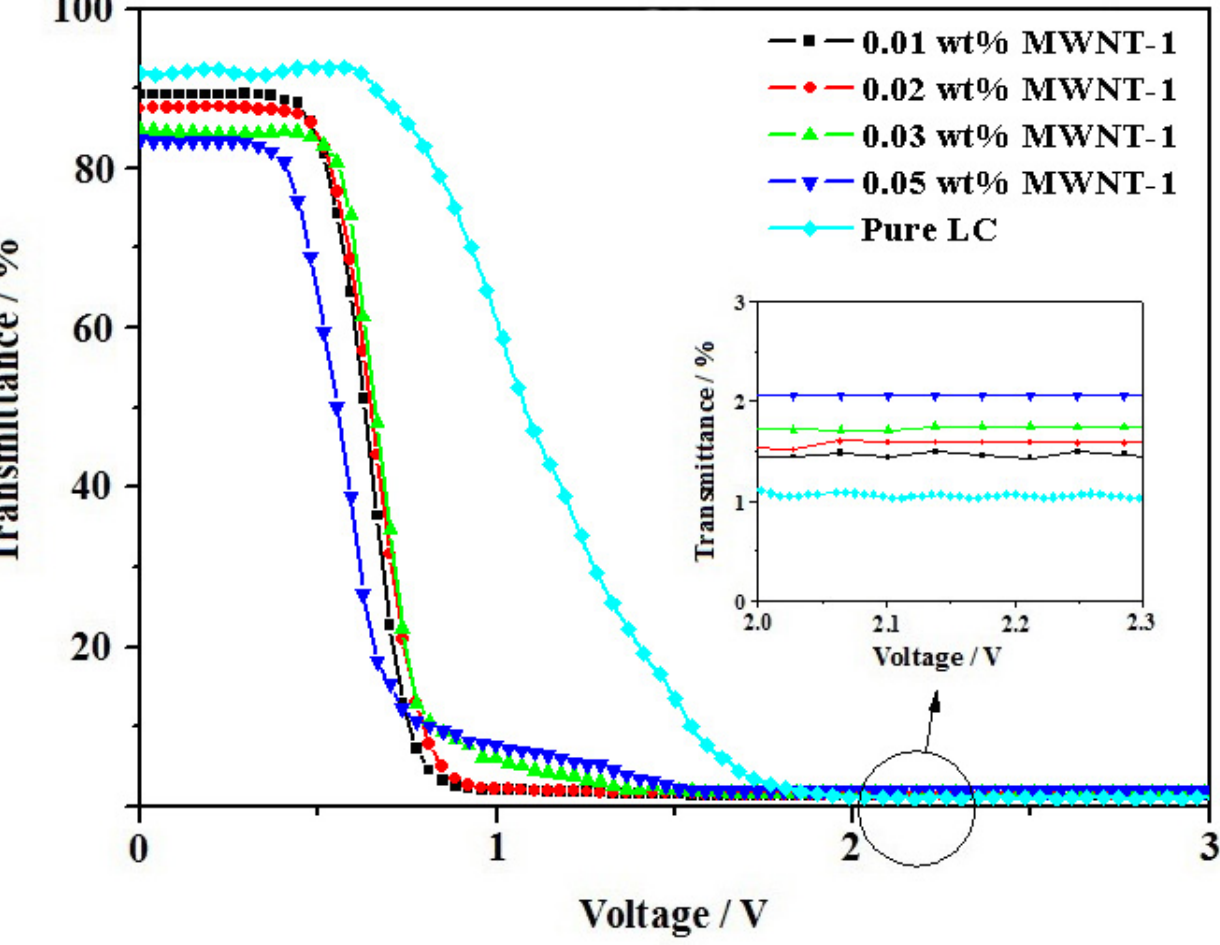
Figure 3. The voltage dependence of the transmittance curves of the TN cells with different concen- trations of MWNT-1 doping.